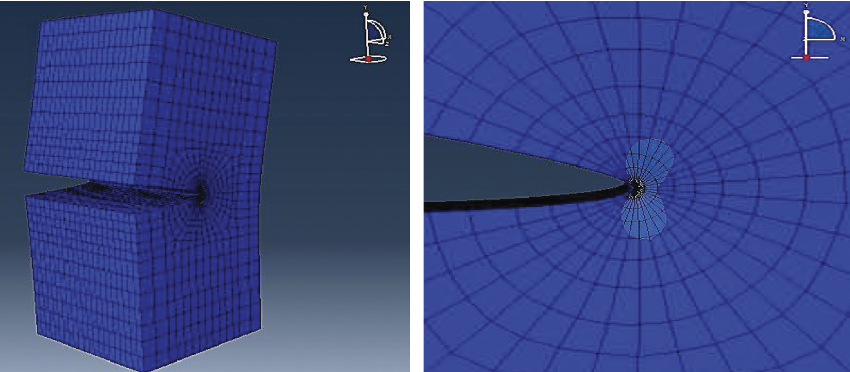
Figure 17: Meshing around the tip of crack and kind of opening of the object under tensile load.